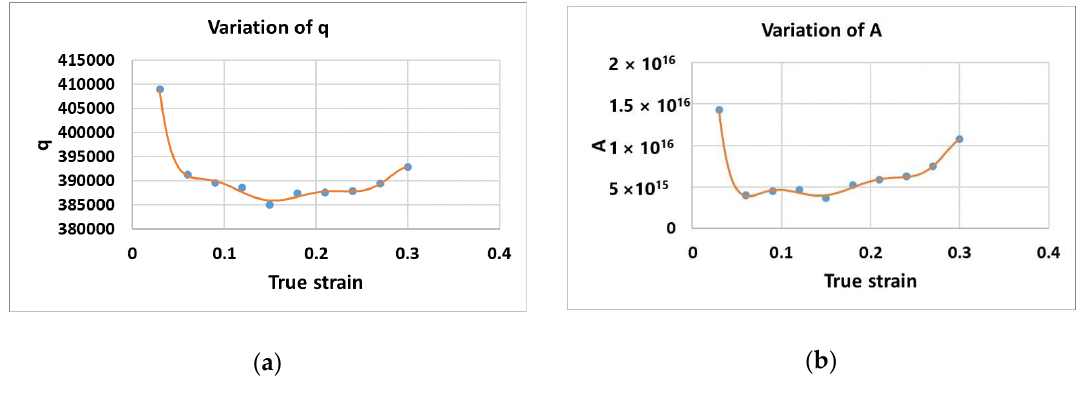
Figure 4. Variation of ( a ) q and ( b )